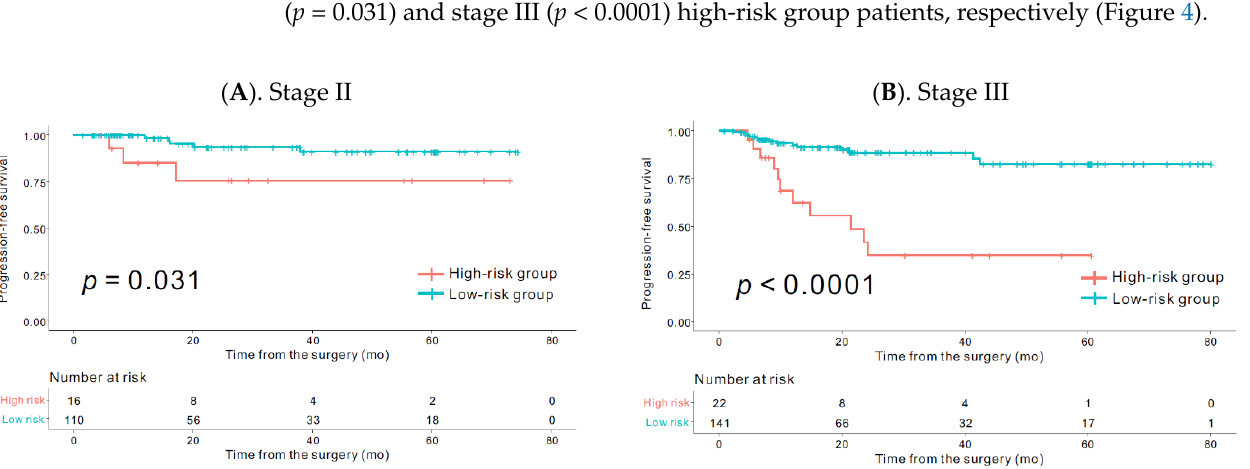
Figure 4. Comparison of progression-free survival of the high- and low-risk groups defined by the radiomics signature according to the stages in the overall (training + validation) set. Kaplan–Meier survival analyses according to the radiomics signature (high-risk group vs. low-risk group) in stage II ( A ) and stage III ( B ). The Kaplan–Meier curve showed that the radiomics signature was significantly associated with PFS in stage II ( p = 0.031) and stage III patients ( p < 0.0001) respectively.